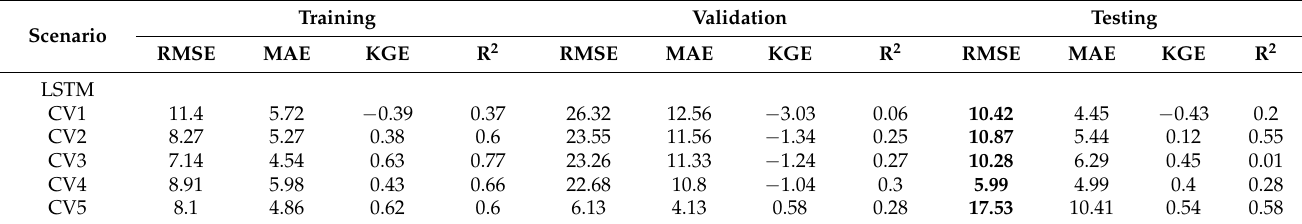
Table 6. Performance of the LSTM scenario for daily streamflow simulation using approach 3 (cross-validation) at TS = 30.